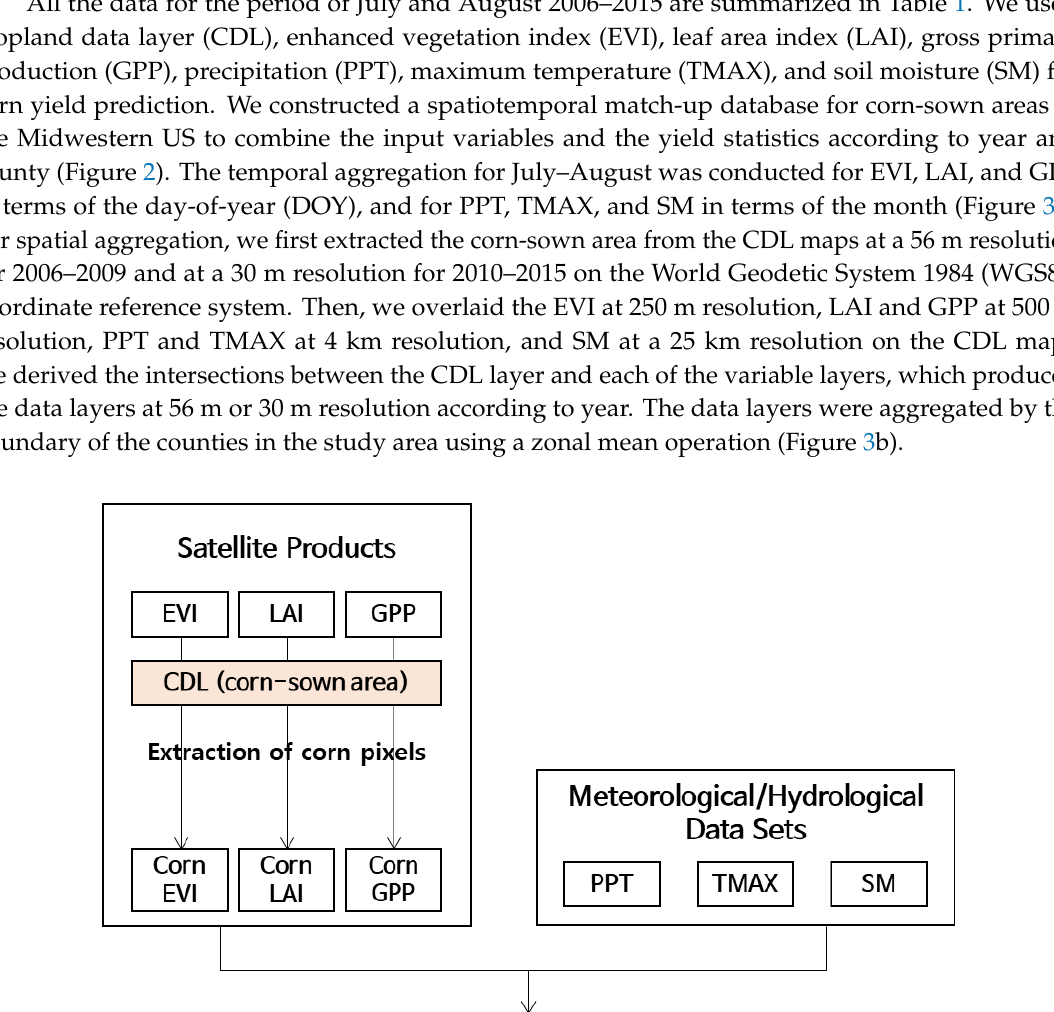
Table 1. The data used for corn yield prediction.